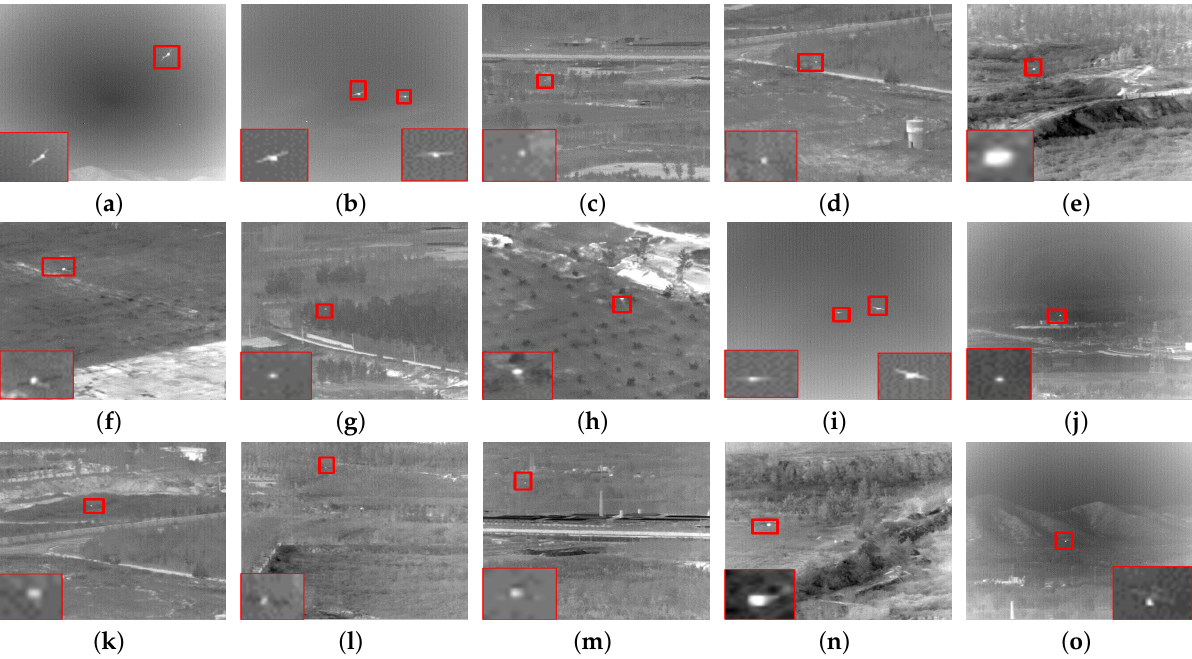
Figure 10. The ( a – o ) corresponds to 15 real sequences used in the